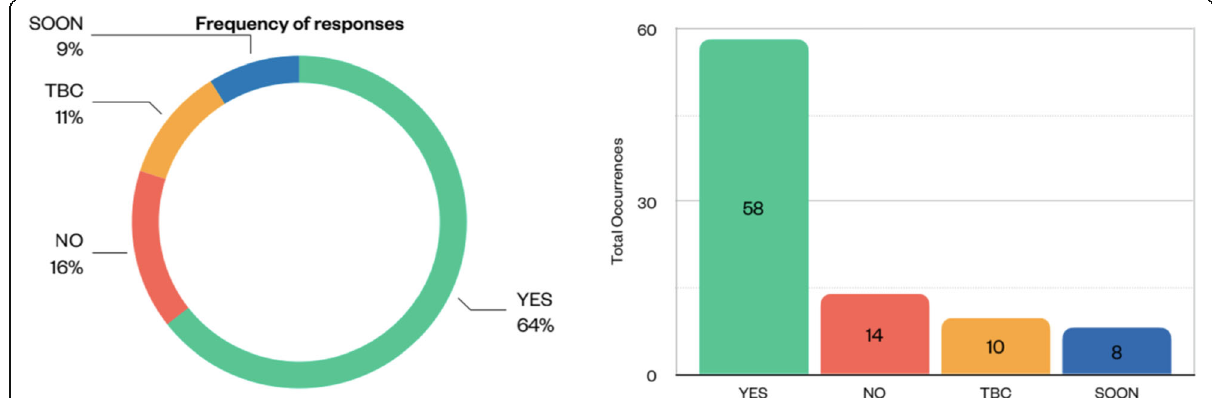
Fig. 2 Level of EuCanImage variable mapping into the Accelerating Research in Genomic Oncology (ARGO) model based on the clinical use cases, at the time of assessment (July 2021). TBC To be